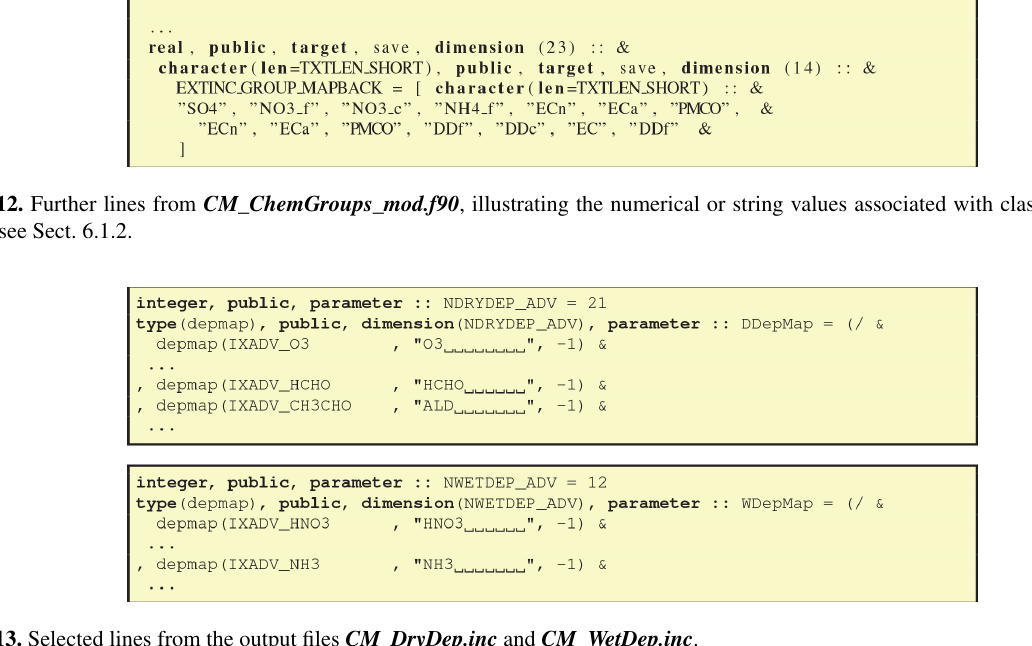
Figure 13. Selected lines from the output files CM_DryDep.inc and CM_WetDep.inc